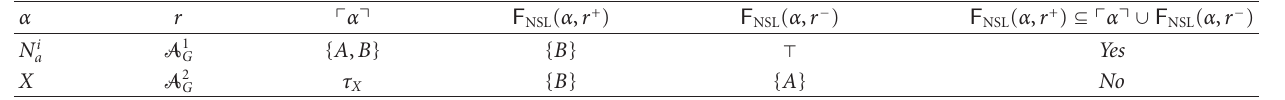
Table 10: Analysis of NSL protocol: role of A.